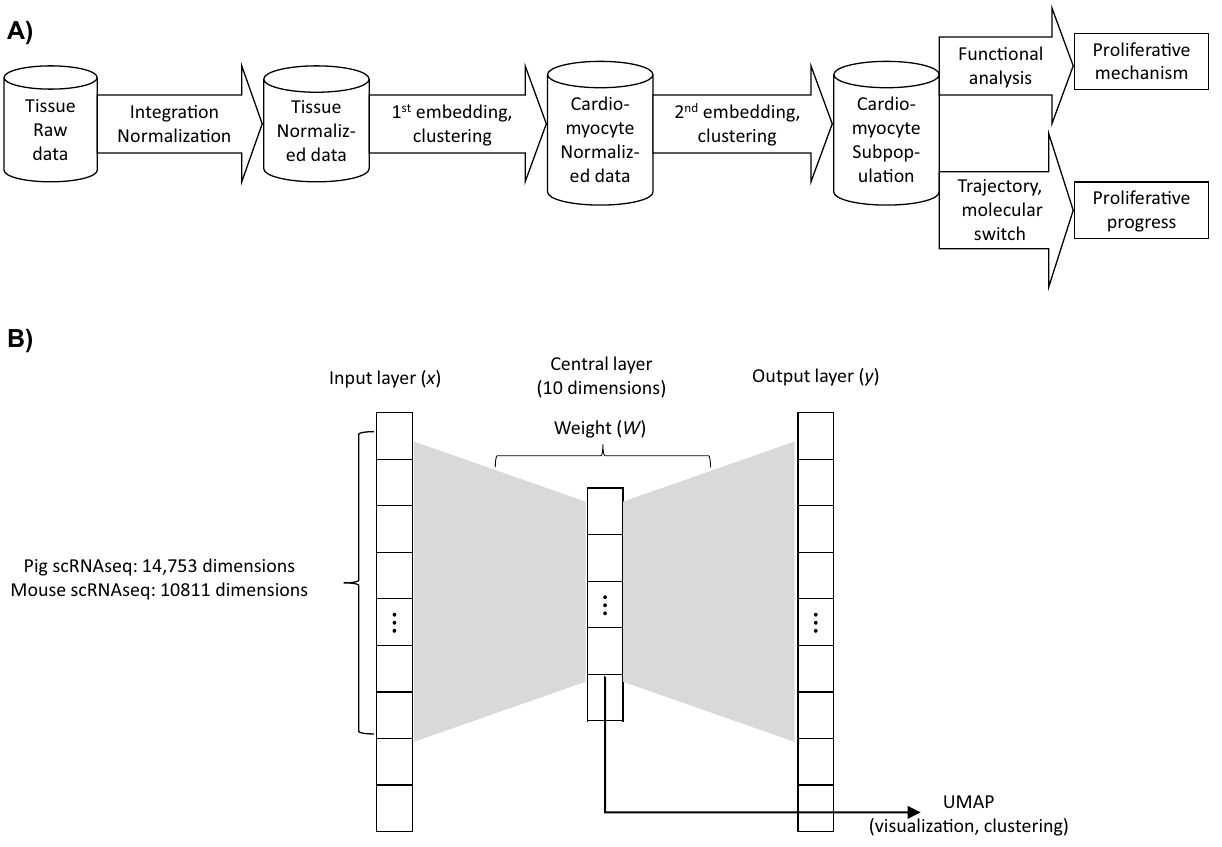
Figure 1. An AI-based approach for processing and interpreting scRNAseq datasets. ( A ) The scRNAseq analytical pipeline is displayed as a flowchart with the data processing steps in arrows and the input and output data for each step displayed as cylinders. ( B ) The architecture of the AI Autoencoder is displayed as a